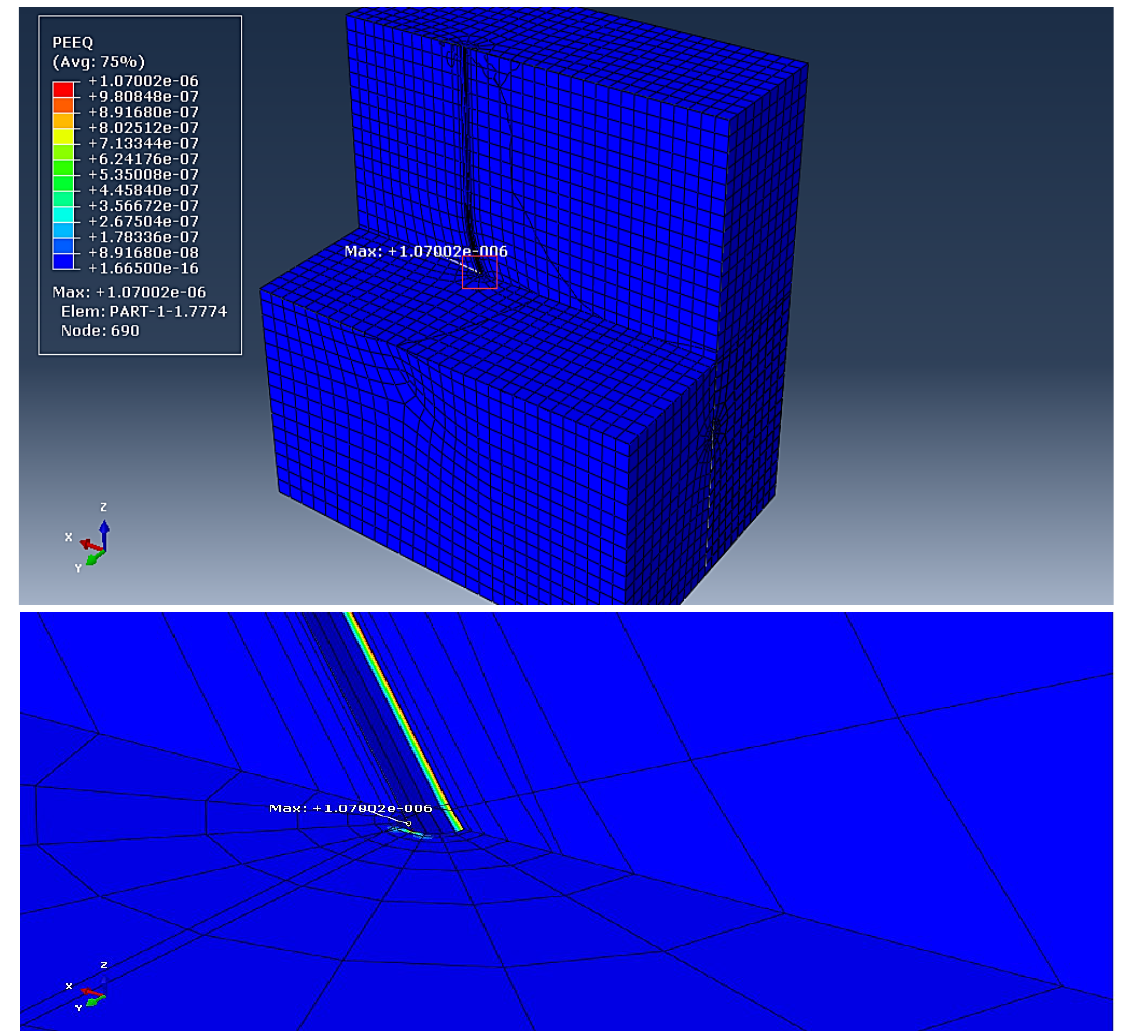
Figure 19. The start of the plastic zone around wellbore-D in an approximate deviation angle of 10° when the mud pressure is less than the lower limit of MWW.